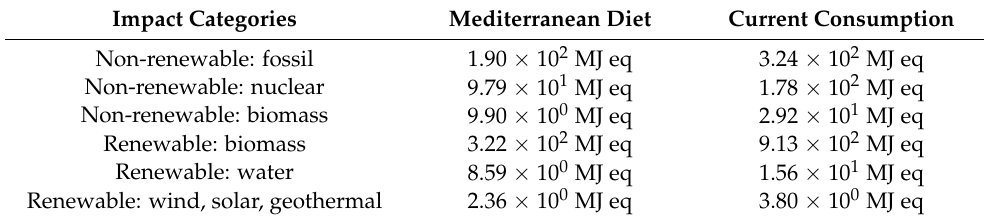
Table 4. Results (MJ eq) of cumulative energy demand.